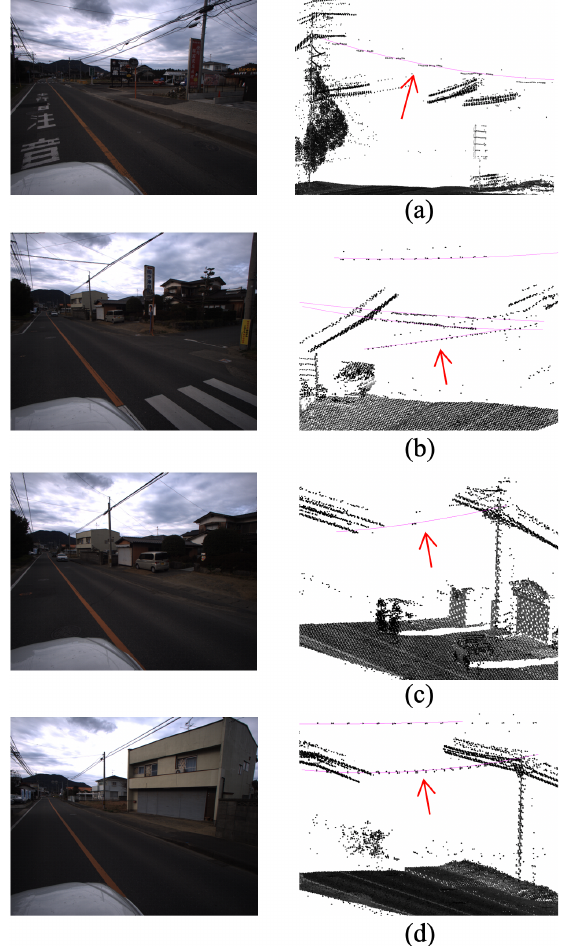
Figure 19. Reconstructed road-crossing